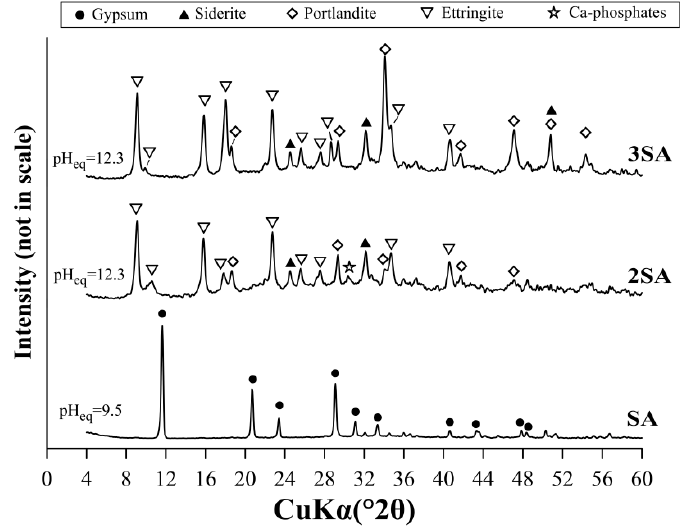
Figure 6. The XRD patterns of solid phases precipitated as a result of AMD treatment by SA, 2SA, and 3SA.